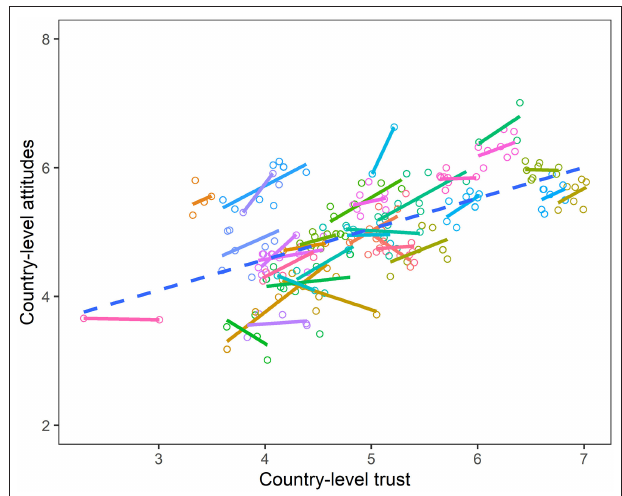
FIGURE 3 | Scatterplot of country-year attitudes about immigrants and social trust.